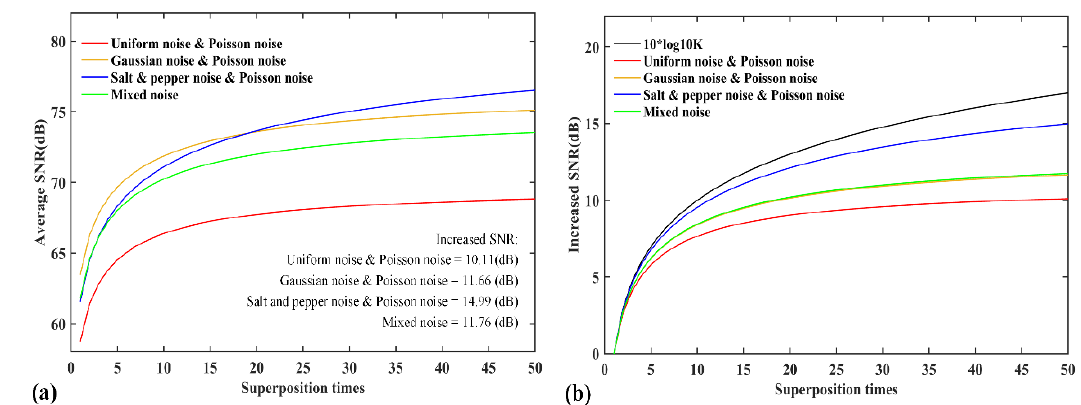
Figure 6. The change of SNRs for the original image signal with four different noise-dominated situations with the increase of the superposition times. ( a ) Average SNR of 50 random simulations at each number of superposition times. ( b ) The increments of SNRs in figure ( a ) with the increase of the superposition times.